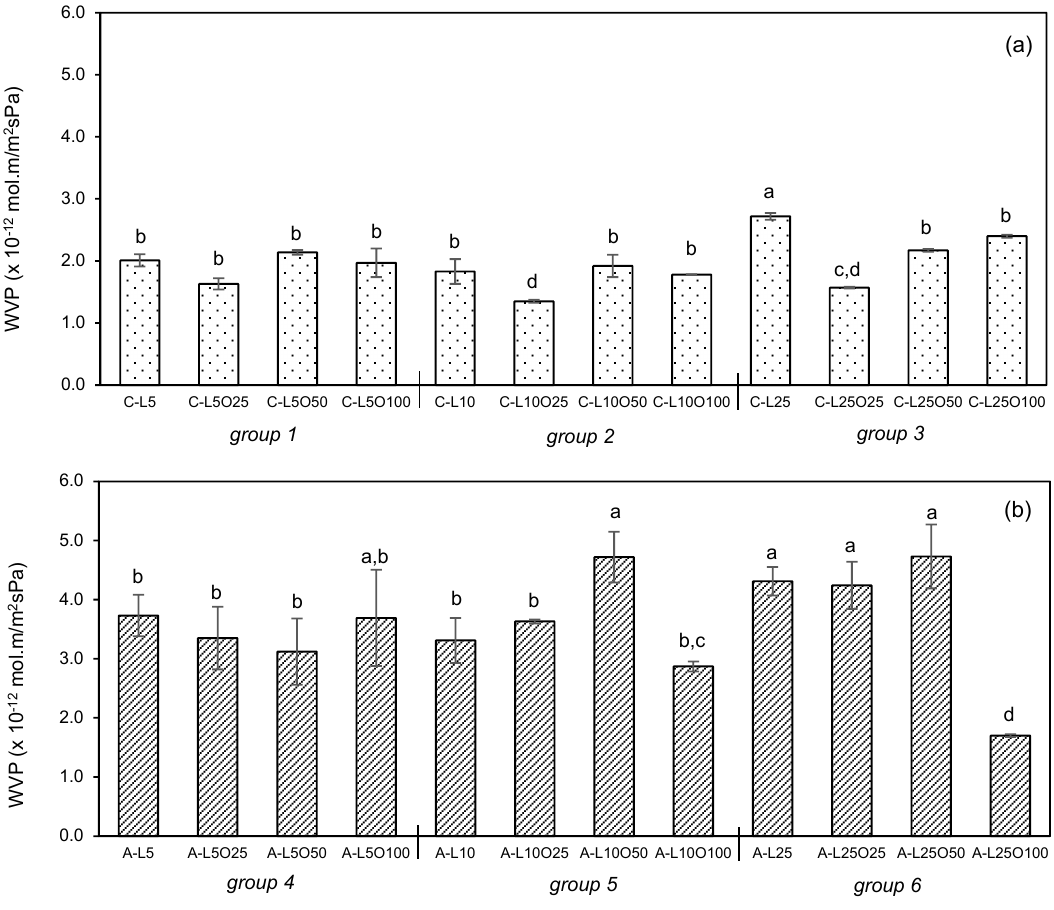
Figure 1. Water vapour permeability (WVP) of ( a ) chitosan and ( b ) alginate-based films, varying the olive oil (O, % w / w ) and soybean lecithin (L, % w / w ) contents according to Table 1. Bars are expressed as mean ± standard deviation. Means in bars with different letters are significantly different ( p < 0.05), based on Tukey’s test performed separately for alginate and chitosan-based films.